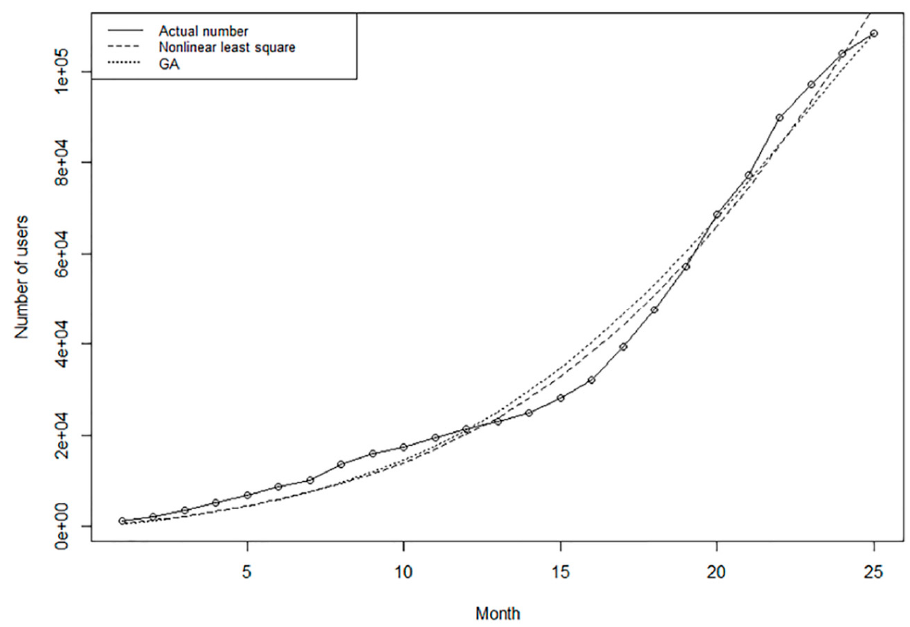
Figure 6. Comparison between the actual cumulative number of new users and fitted values of the